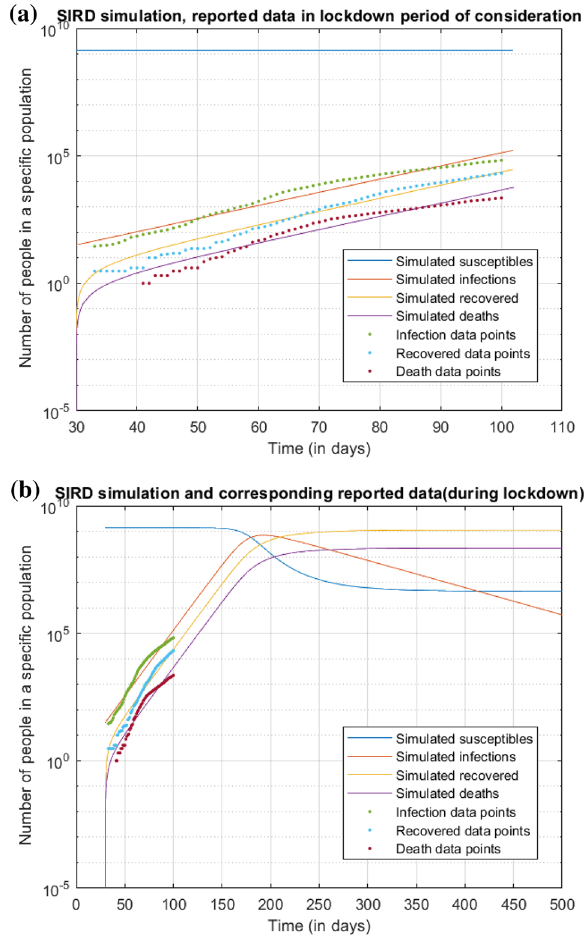
Figure 8. Simulating the prediction curves by using the best fit over the entire range of data. ( a ) depicts the data points and respective curves with α = 0.144 , β = 0.021 and γ = 0.0041 ( b ) represents the same curve with the time axis extended upto 1000 days, thus giving a trend of the infection.